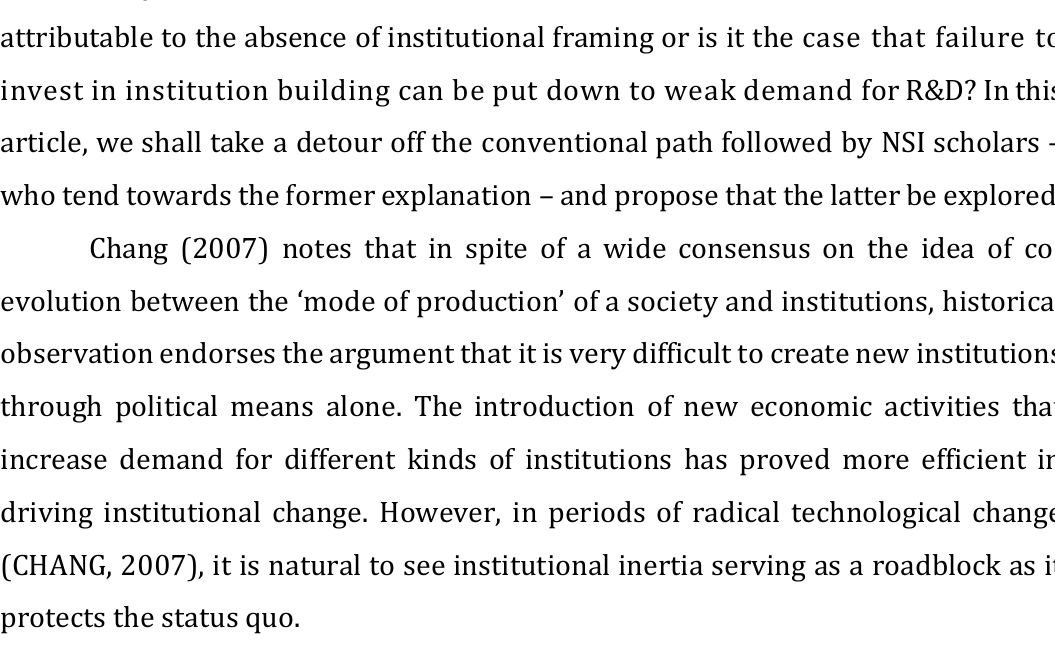
Figure 01 . U.S. GERD and U.S. R&D offshore, 1997 –